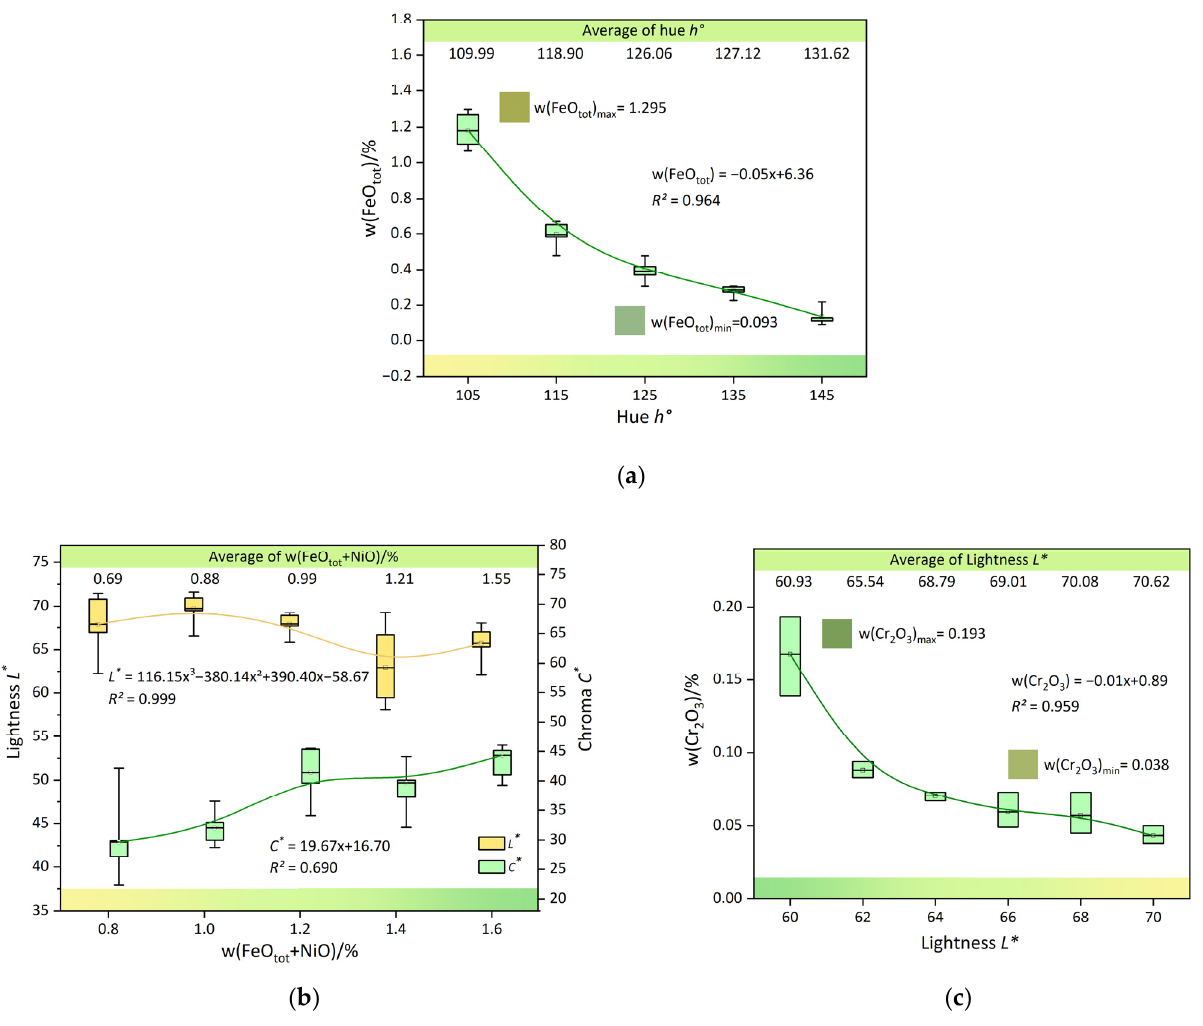
Figure 4. Relationship between color parameters and transition-metal elements. ( a ) There is a high negative correlation between w(FeO tot ) and the hue h° of opal; ( b ) With the increase of w(FeO tot + NiO), the chroma C* increases, and w(FeO tot + NiO) has a low negative correlation with the lightness L* ; ( c ) With the increase of Cr content, the lightness L* decreases. Table 2. Results of bivariate correlation analysis. ** At level 0.01 (double tail), the correlation was significant.